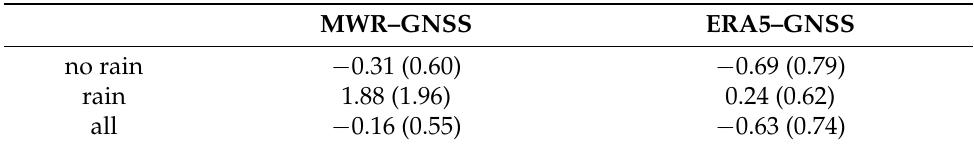
Table 4. Mean differences of IWV (mm) and RMSE of MWR (microwave radiometer) and ERA5 with respect to GNSS. The deviations are listed for the different atmospheric states at Bern using the monthly means of Figure 5. Rain periods are indicated by ILW ≥ 0.4